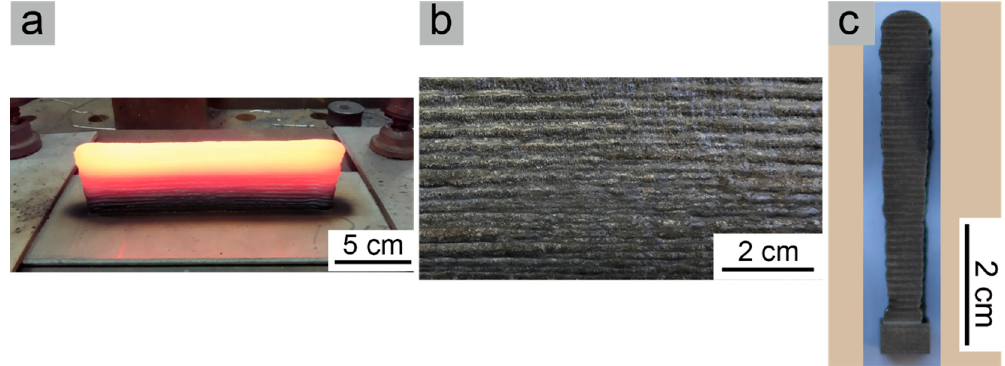
Figure 3. Macro morphology of the as-deposited wall: ( a ) Overall appearance of the as-deposited wall, ( b ) surface bead of the as-deposited wall, and ( c ) middle cross-section.